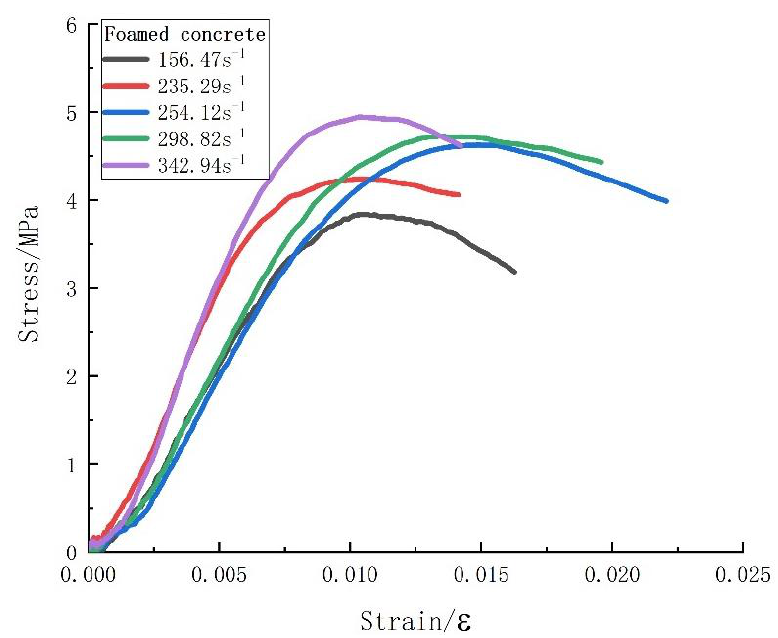
Figure 14. Stress – strain curve of foam concrete.